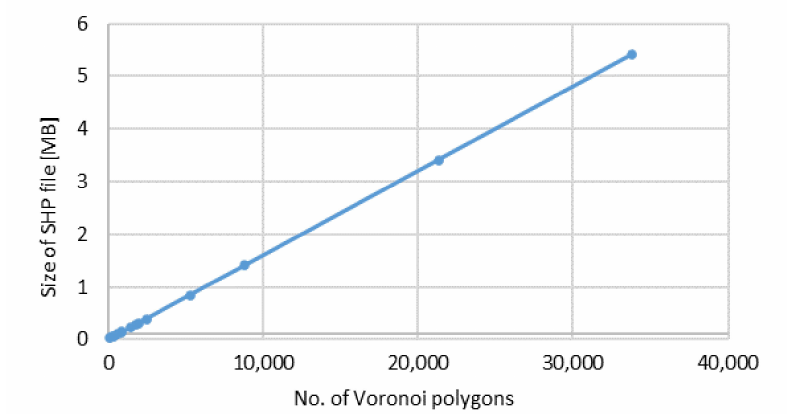
Figure 14. Diagram of the correlation between the file size and the number of generated Voronoi